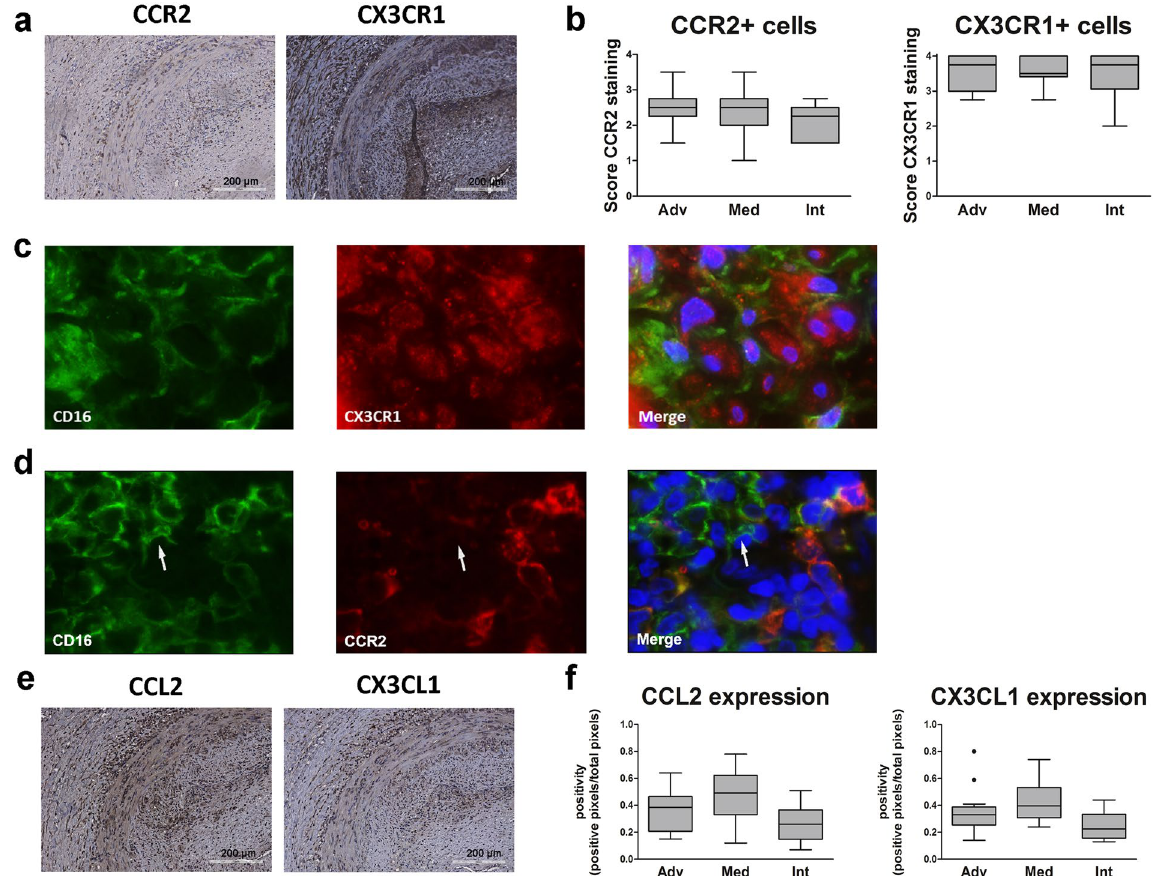
Figure 5. Expression of CCR2, CX3CR1 and their ligands in GCA temporal artery biopsies. ( a ) Immunohistochemical (IHC) staining for CCR2 and CX3CR1 in a representative temporal artery biopsy diagnostic of GCA. Note that consecutive sections of the same tissue were used in Figs 3 and 5. ( b ) Semi- quantitive score of CCR2-, CX3CR1-postive cells in the inflammatory area of GCA TAB (n = 15 and n = 16, respectively). Intensity of staining was not taken into account. Scores are given for the adventitia (Adv), media (Med, infiltrating cells only) and intima (Int). Data are presented as Tukey box and whisker plots. The bottom and top of the box represent the first and third quartiles, and the band inside the box represents the second quartile (the median). The whiskers represent the 1.5 IQR of the lower and the upper quartiles. ( c ) Co-localization of CD16 and CX3CR1 in TAB from GCA patients. Single staining for CD16, CX3CR1 and double staining for CD16 and CX3CR1, respectively from left to right in the inflammatory area of a TAB section. Blue = DAPI staining of nuclei; Green(FITC) = CD16 expression, Red(AF555) = CX3CR1 expression. ( d ) CCR2 and CD16 rarely co-localize in TAB from GCA patients. Single staining for CD16, CCR2 and double staining for CD16 and CCR2, respectively from left to right in the inflammatory area of a TAB section. Blue = DAPI staining of nuclei; Green(FITC) = CD16 expression, Red(AF555) = CCR2 expression. ( e ) IHC staining for CCL2, CX3CL1 in a representative TAB. ( f ) Quantification of staining intensity (positive pixels/total number of pixels) of CCL2 and CX3CL1 in the inflammatory vessel wall (n = 16 for both markers). Data are presented as Tukey box and whisker plots. The bottom and top of the box represent the first and third quartiles, and the band inside the box represents the second quartile (the median). The whiskers represent the 1.5 IQR of the lower and the upper quartiles. Outliers are plotted as